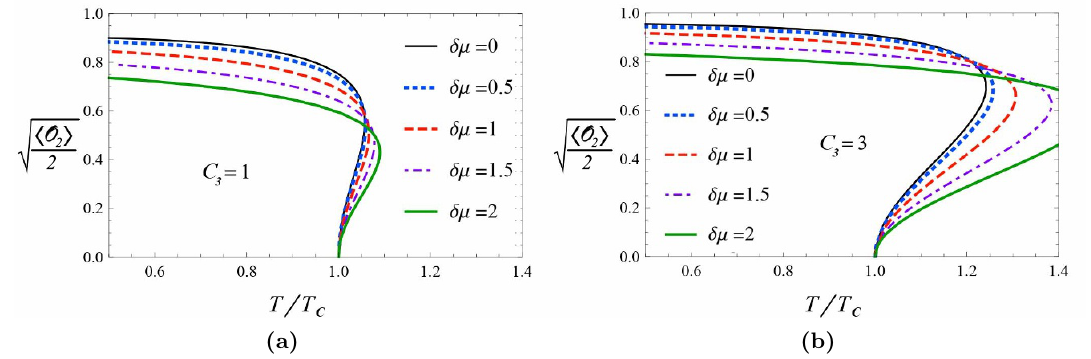
Figure 5. The value of the condensate as a function of the temperature for function F ( ) = 2 + C 3 with C 3 3 = 1 ; 3 (left plot, right plot) and (cid:14)(cid:22) = 0 ; 0 : 5 ; 1 ; 1 : 5 ; 2.